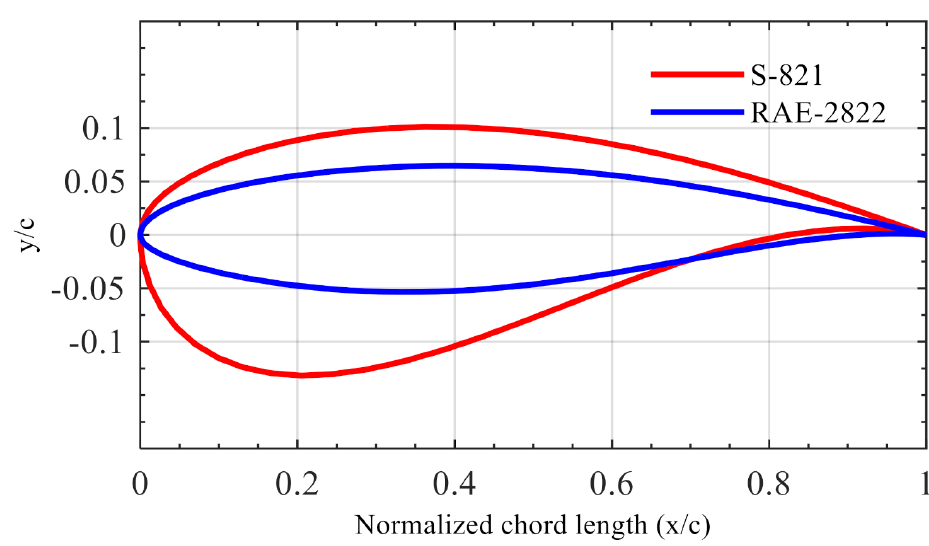
Figure 2. Optimized airfoil shape